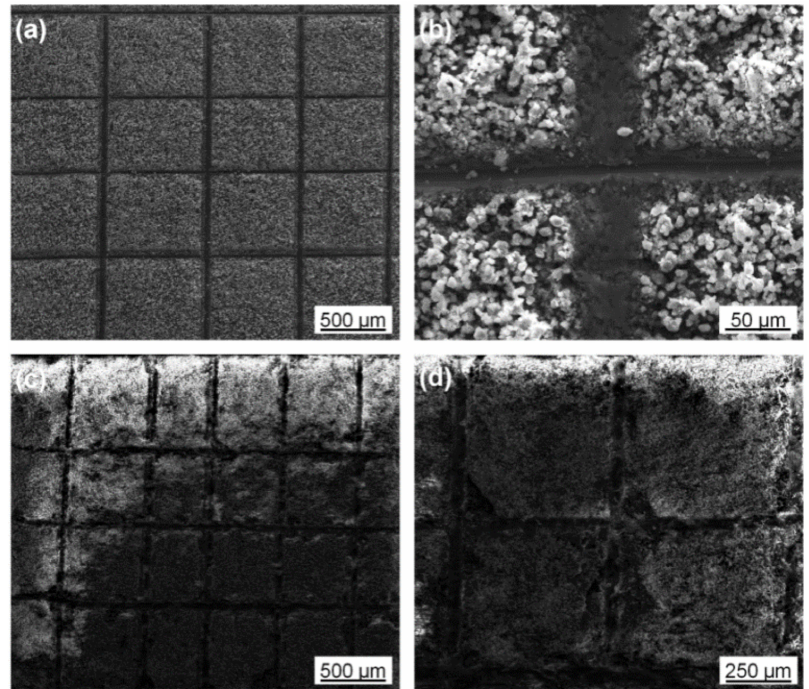
Figure 5. SEM micrographs of the samples HT2 ( a , b ) and HT3 ( c , d ) after adhesion test.